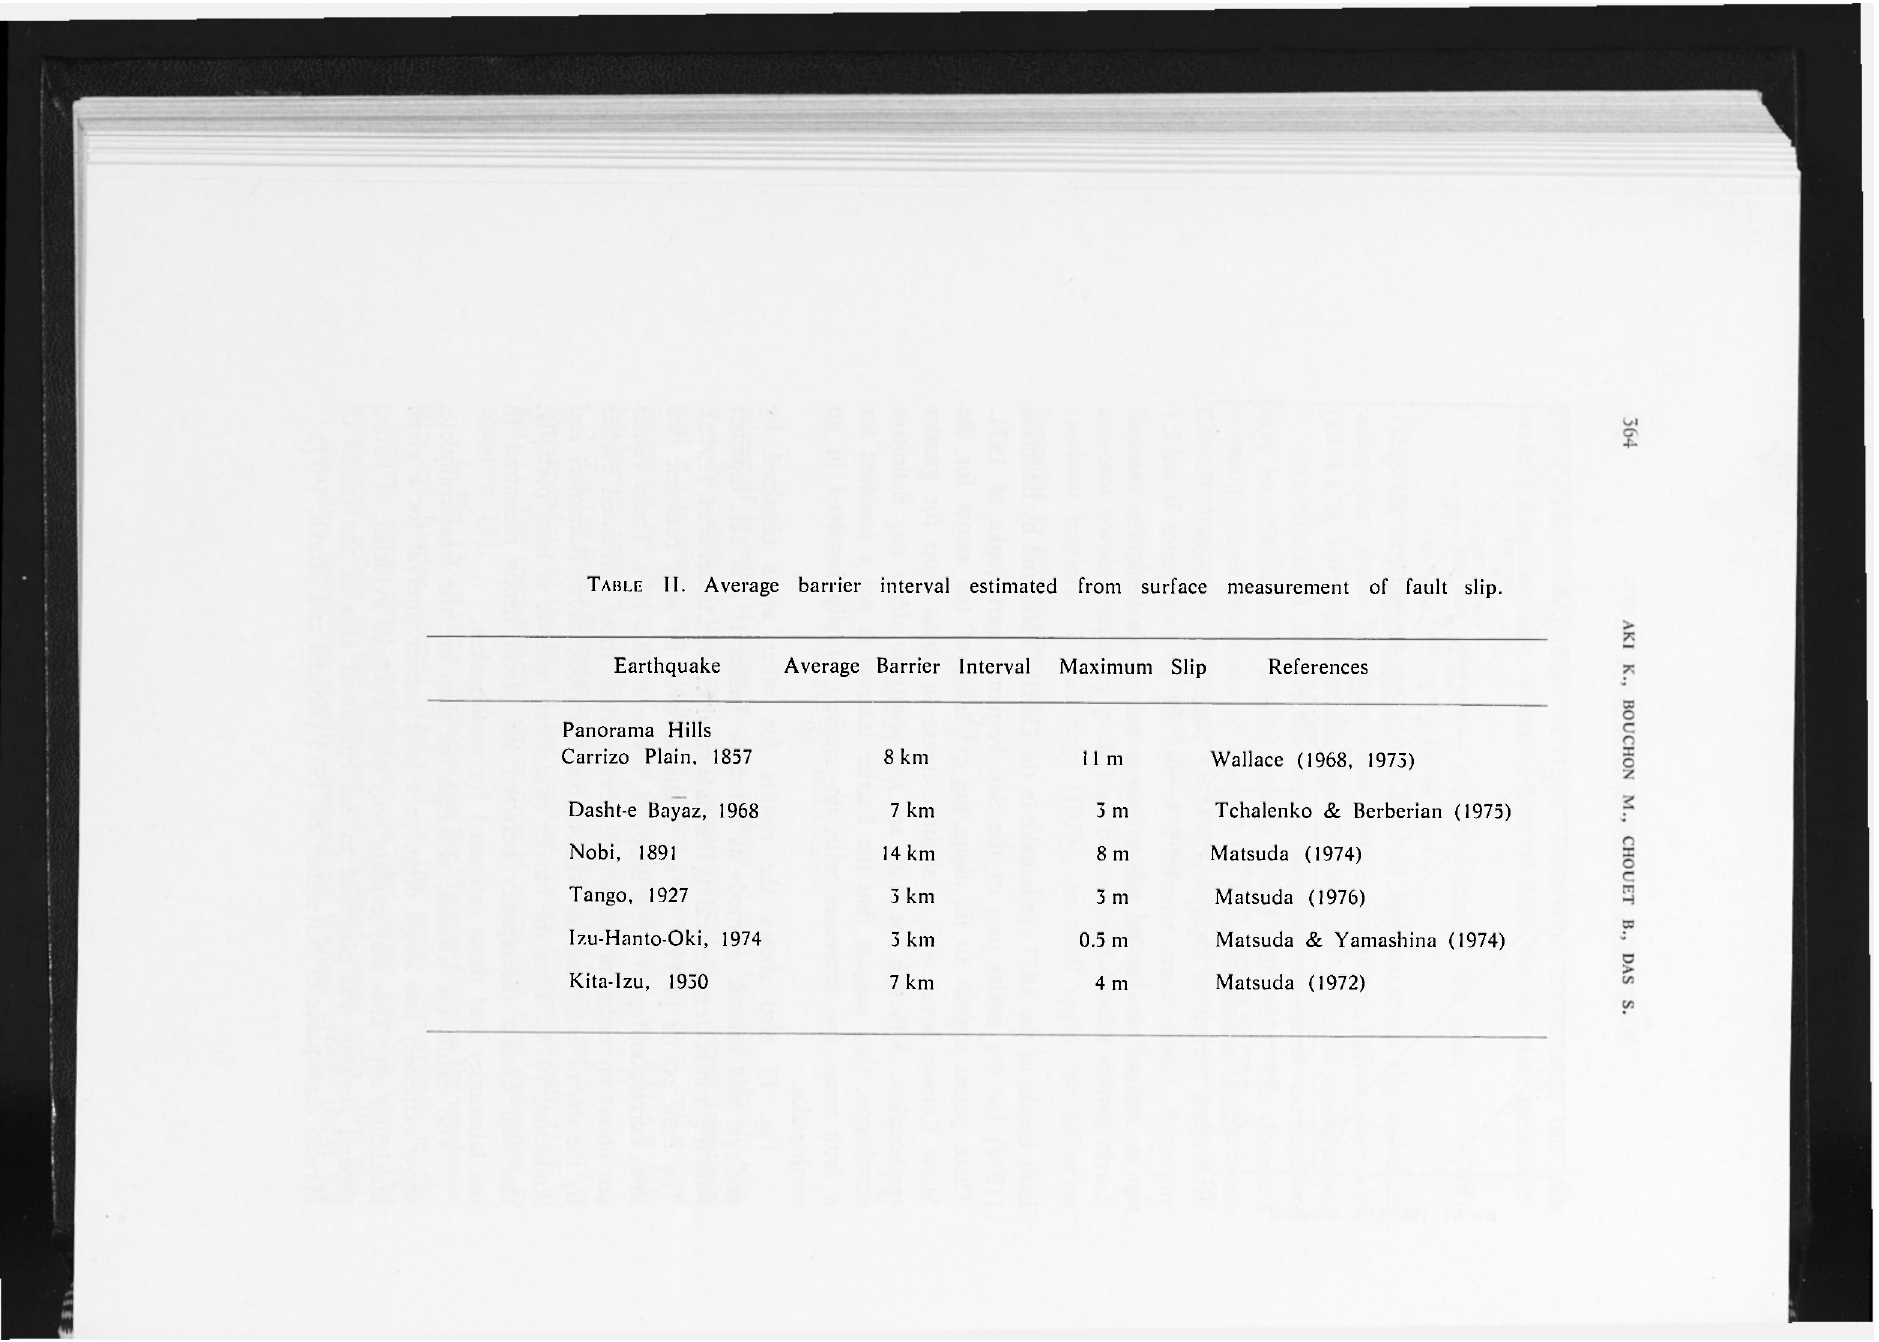
TABLE II. Average barrier interval estimated from surface measurement of fault